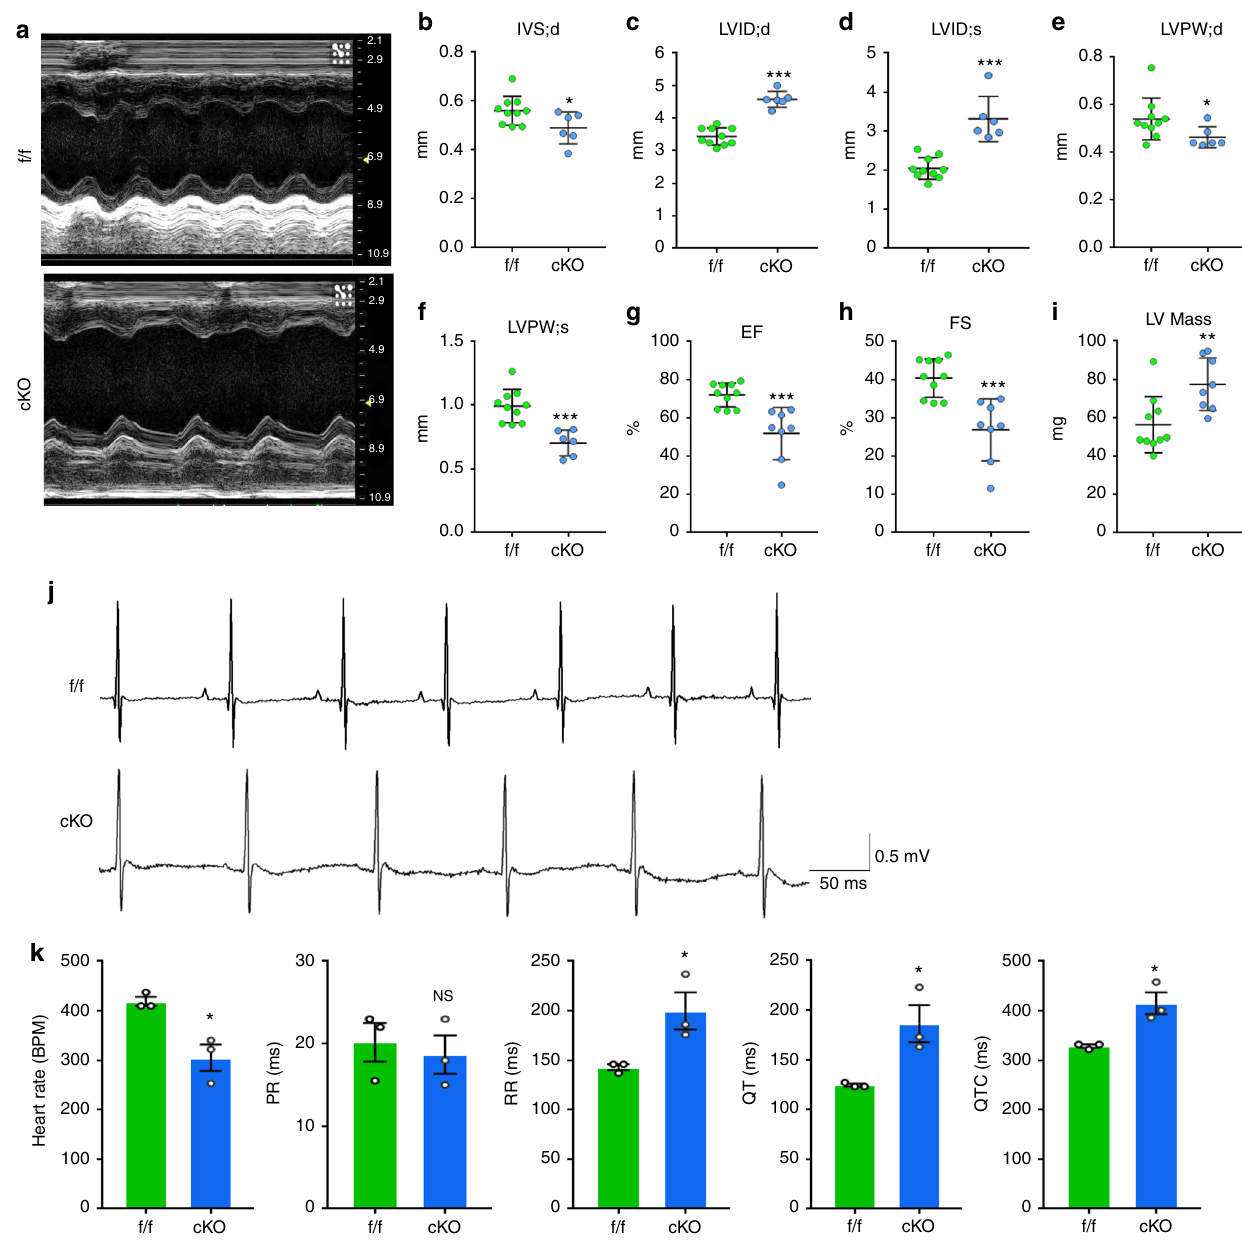
Fig. 2 Cardiac-speci fi c deletion of PRMT1 results in reduced cardiac function and increased mass. a The short axis transthoracic M mode echocardiographic tracings from 7-weeks-old f/f and cKO mice. b – i Echocardiographic parameters. IVS;d the interventricular septum;diastolic, LVID;d or LVID;s the internal dimension of left ventricle (LV); diastolic or systolic, LVPW;d or LVPW;sthe postwall thickness of LV; diastolic or systolic. EF the ejection fraction, FS the fraction shortening, LV Mass Left ventricular mass ( n = 7 – 10 per group). Data represent means ± SEM. * P < 0.05, ** P < 0.01, *** P < 0.001, Student ’ s t -test. j A representative ECG recording of spontaneous bradycardia in 7-weeks-old cKO and a normal ECG recording in f/f littermate. k Bar plots of heart rate and EKG intervals in f/f and cKO mice show the decreased heart rate and the prolonged QT interval in cKO mice. Data represent means ± SEM. * P < 0.05, Student ’ s t